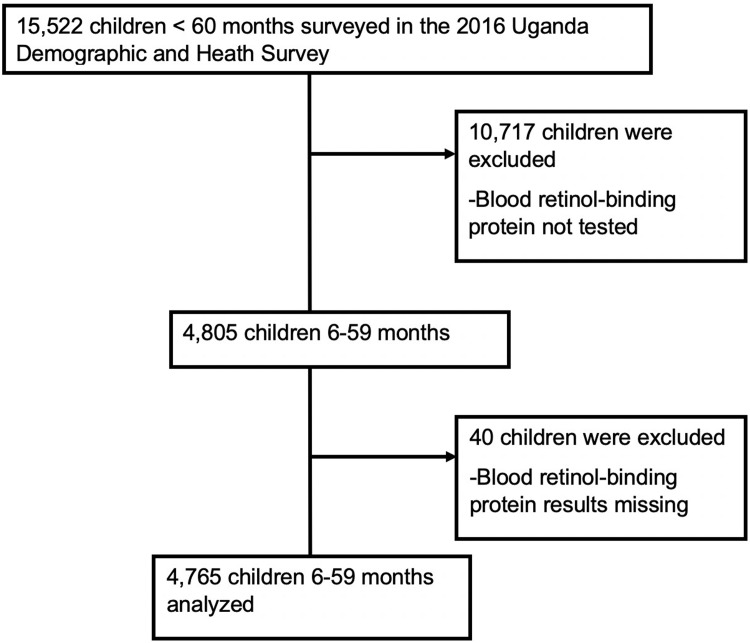
Flow of study participant selection.